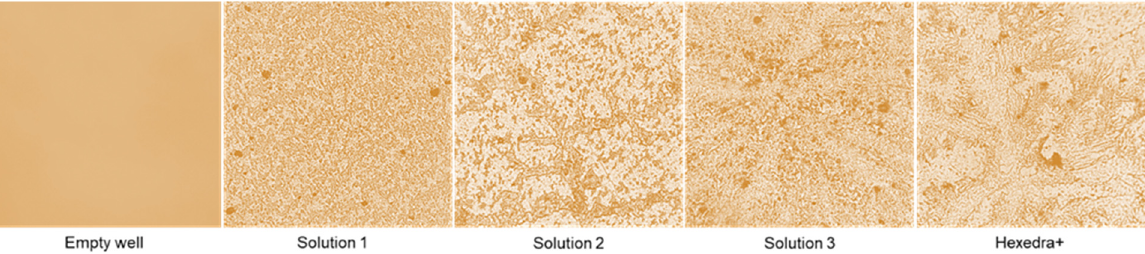
Figure 1. Crosslinking analysis by staining. The images reported are an example obtained from each treatment obtained at 40× magnification from four technical replicates.